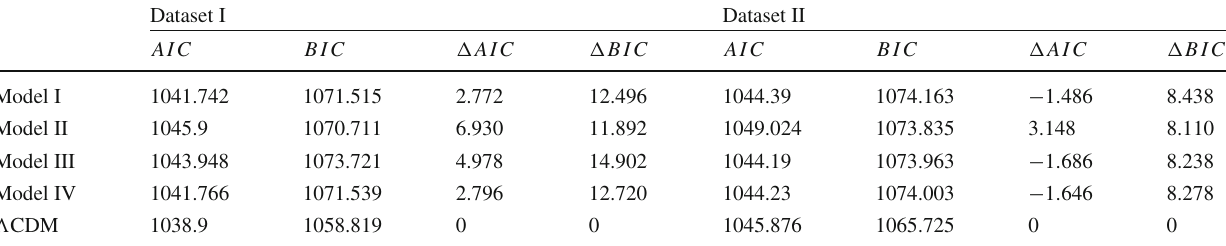
Table 3 The values for the AIC and BIC for the different models